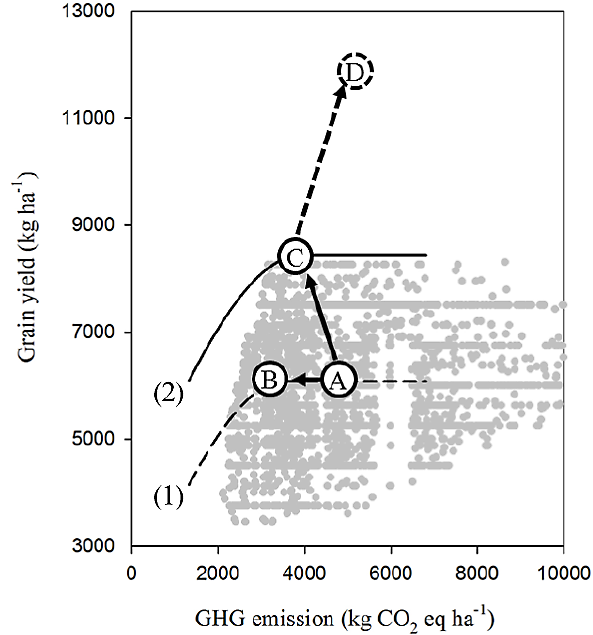
Fig. 2. A stylized grain yield–GHG emission framework demon- strating three pathways to produce higher yields with less GHG emissions. The gray dots represent grain yields and GHG emissions for the 2938 farmers surveyed. The line of dashed line (1) and solid line (2) mean relationship between grain yield and GHG emission for CP and HY system, respectively. Point A is the average for all farmers; points B and C are the minimum GHG emissions for max- imum grain yield with the CP and HY system, respectively (the details are shown in Fig. 3); and point D represents the target of 12Mgha − 1 of wheat grain yield in the